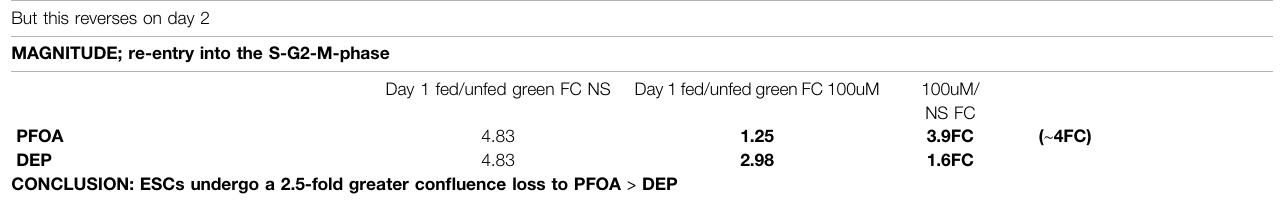
But this reverses on day 2 MAGNITUDE; re-entry into the